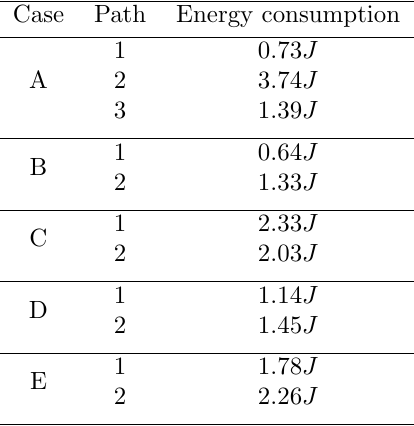
Table 2: Metabolic energy consumption for different